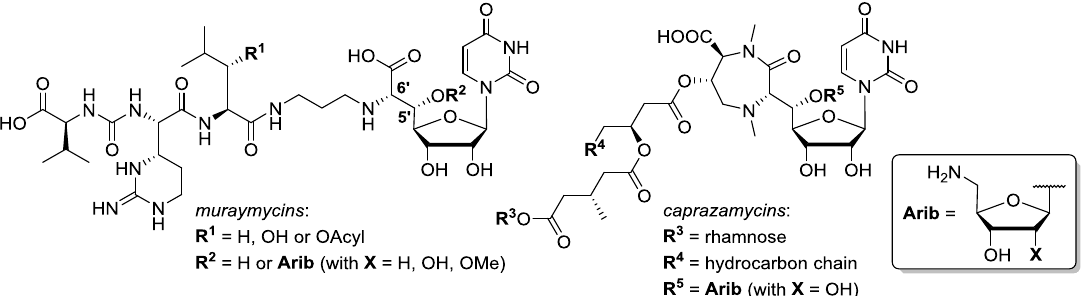
Figure 1. Structures of the nucleoside-peptide antibiotics muraymycins and caprazamycins.